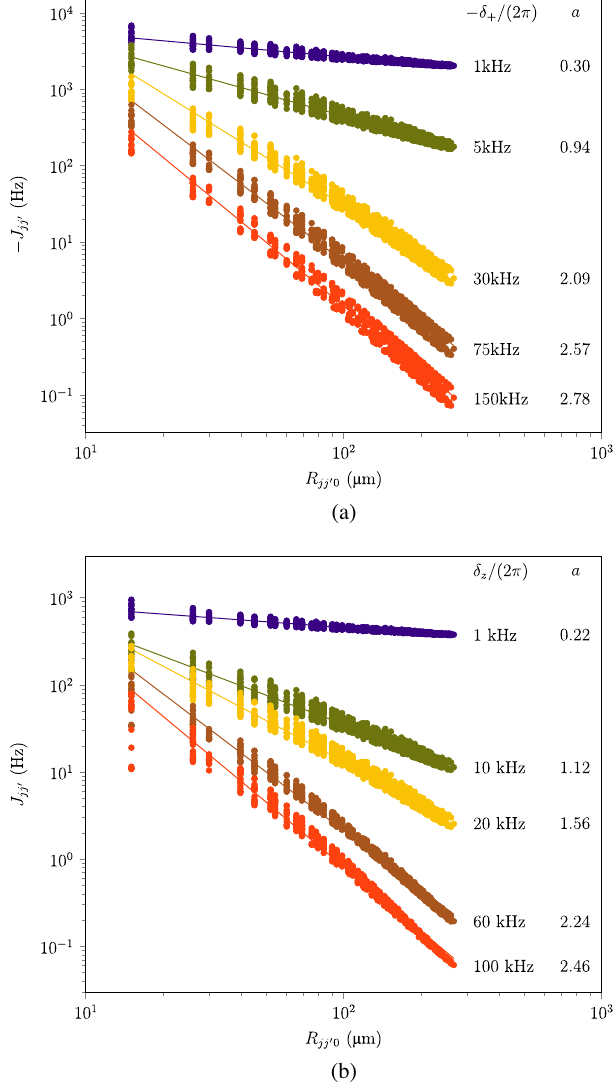
FIG. 7. Spin-spin couplingterms generated with an optical dipole force for a 204-ion honeycomb lattice ( d ¼ 15 μ m) arranged with the tilted geometry ( Θ ¼ 20 °).The ODF can becreated bytwolaser beams along the plane of the electrodes so that the difference wave k k vector is given by k cos Θ ˆ e sin Θ ˆ e . When the beat R ¼ R x þ R z lies to the red of the cyclotron branch, all note frequency μ R couplings are negative, and a ferromagnetic Ising interaction can be engineered. These couplings follow an approximate power-law ∝ 1 = j R a , and the exponent a increases with an decay j J jj 0 j jj 0 0 j = ℏ ¼ 2 π × 300 kHz. increasingmagnitude of δ . Here, E ¼ μ R − ω O þ þ Similar tunable ferromagnetic couplings can be achieved by tuning to the blue of the magnetron COM mode. For the radial modes, lasers parallel to the electrode plane can also be used to create a wave-vector difference along the ˆ y axis. When μ is increasingly R μ − ω tunedawayfromtheaxialbranchsothat δ increases,all z ¼ R z couplingsarepositive,and,hence,variable-rangeantiferromagnetic Ising-like interactions can be generated with a going from 0 to 3. The strength of these couplings is limited by the angle of tilt Θ . Use of laserless methods could eliminate this restriction. (a) Cyclotron branch, (b) Axial